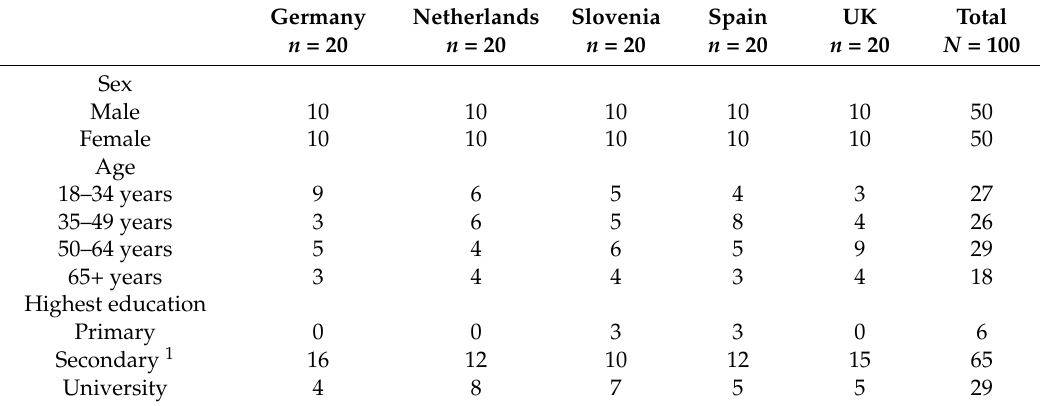
Table 1. Sociodemographic characteristics of participants by